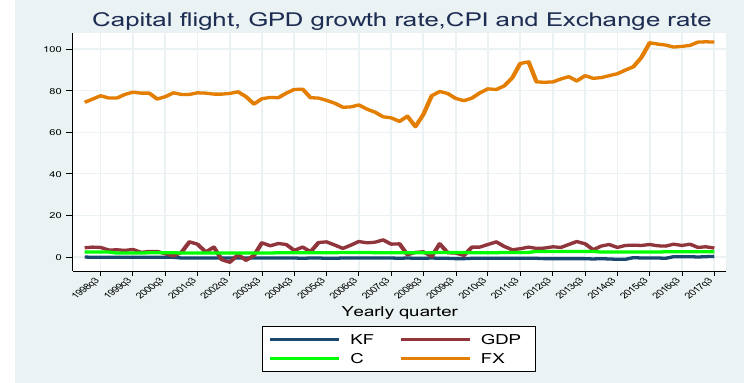
Figure 5: Trend analysis of the